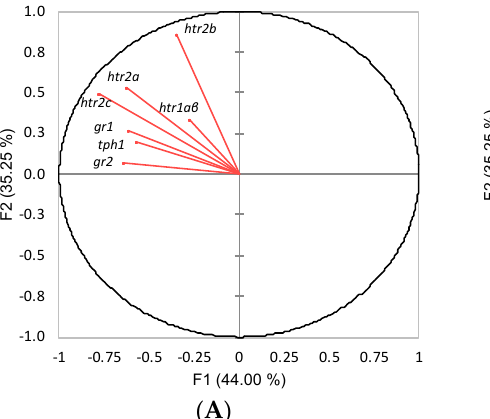
Figure 4. Canonical discriminant analysis of European seabass optic tectum expression of HPI-axis- related genes. ( A ) Correlation variables/factors (factor loads) for two main discriminant functions (F1 and F2); gr1 , glucocorticoid receptor 1; gr2 , glucocorticoid 2; htr1a β , serotonin receptor 1A β ; htr2a , serotonin receptor 2A; htr2b , serotonin receptor 2B; htr2c , serotonin receptor 2C; tph1 ,